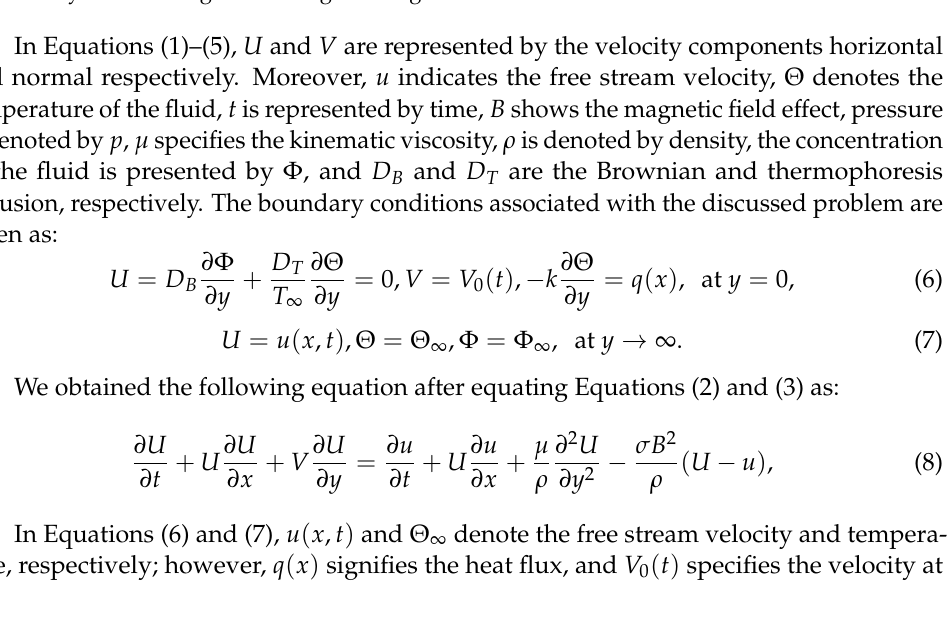
Figure 1. Systematic diagram of the governing model.